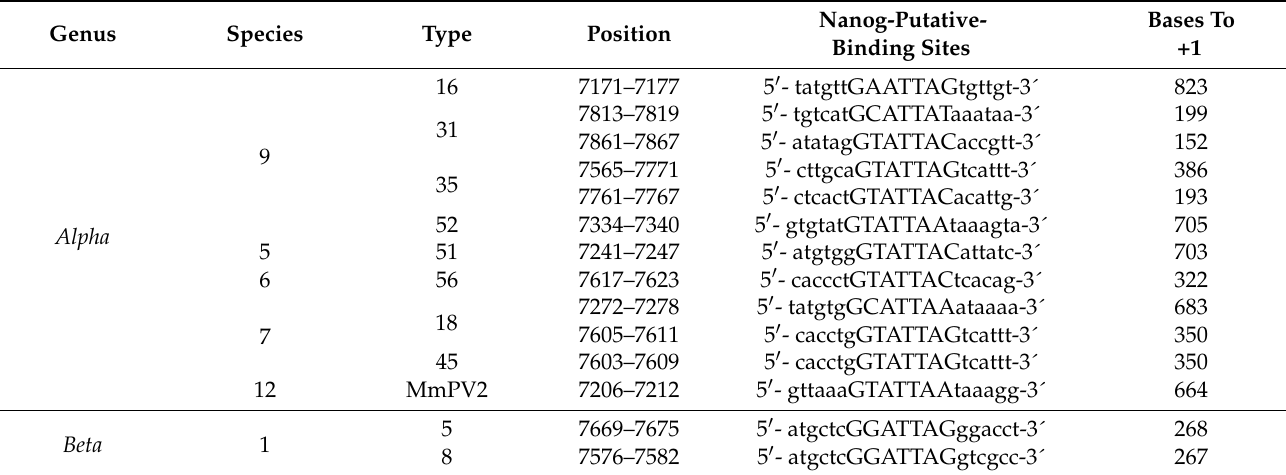
Table 1. Nanog putative binding sites found in the LCR of Alpha- and Betapapillomavirus . Genus